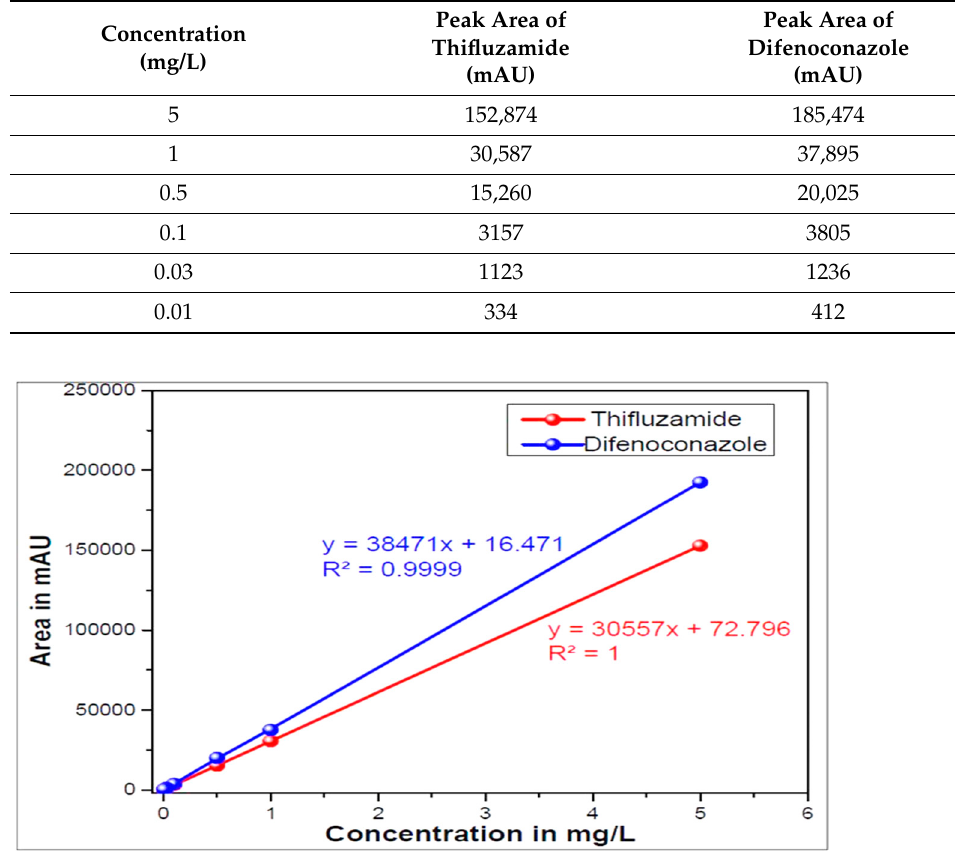
Figure 4. Calibration curve of linearity standards.